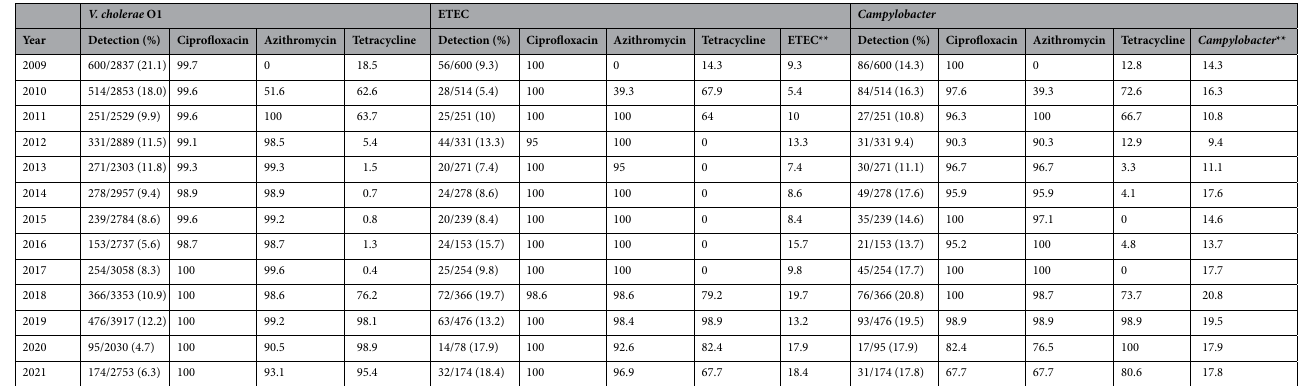
Table 3. The antibiotic susceptibility trends in the co-pathogens along with V. cholerae (2009–2021). **Detection rate as co-pathogen, unit =